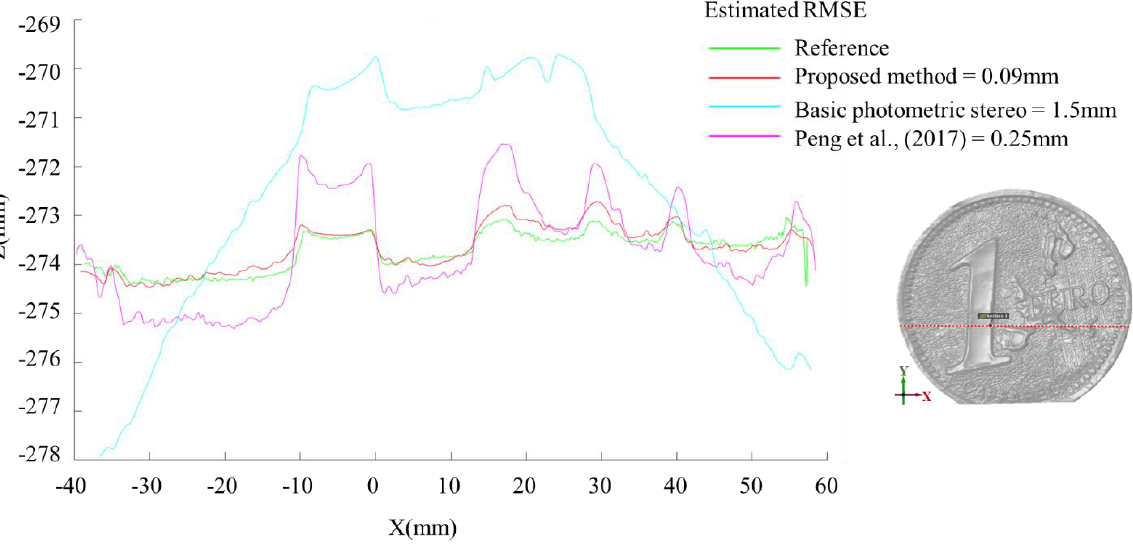
Figure 13. The comparison result of profiling for object F. The green profile represents the reference data (photogrammetry), the red profile represents proposed method, the blue represents basic photometric stereo, and the magenta profile represents the algorithm implemented in [51].